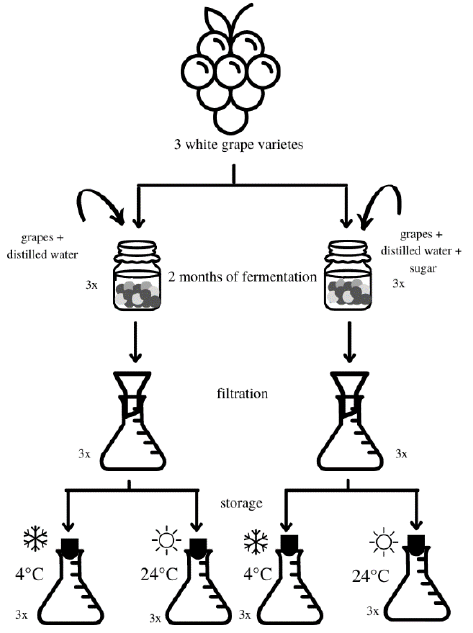
Figure 3. Flow chart of vinegar sample preparation and storage process.